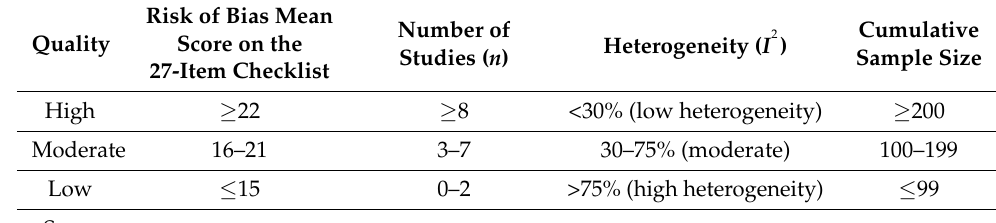
Table 4. Confidence in cumulative evidence scale that will be used when the GRADE is not